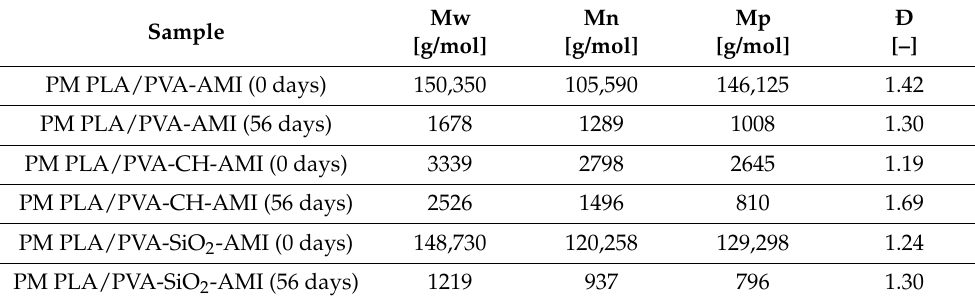
Table 8. GPC results after 0 and 56 days of degradation in PBS